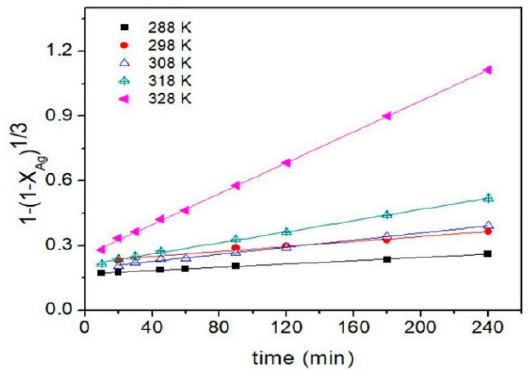
Figure 12. Assessment of the application of the chemical control model on the conversion values of Ag in function of time for the study of the temperature effect in the S 2 O 32 − -O 2 system, (V = 0.5 L, 40 g ∙ L − 1 Mineral, PO 2 = 1 atm, pH = 10, leaching time = 240 min, [S 2 O 32 − ] = 0.16 mol ∙ L − 1 , [Cu 2+ ] = 0.006 mol ∙ L − 1 , 298 K (25 °C), RPM = 750 min − 1 ).